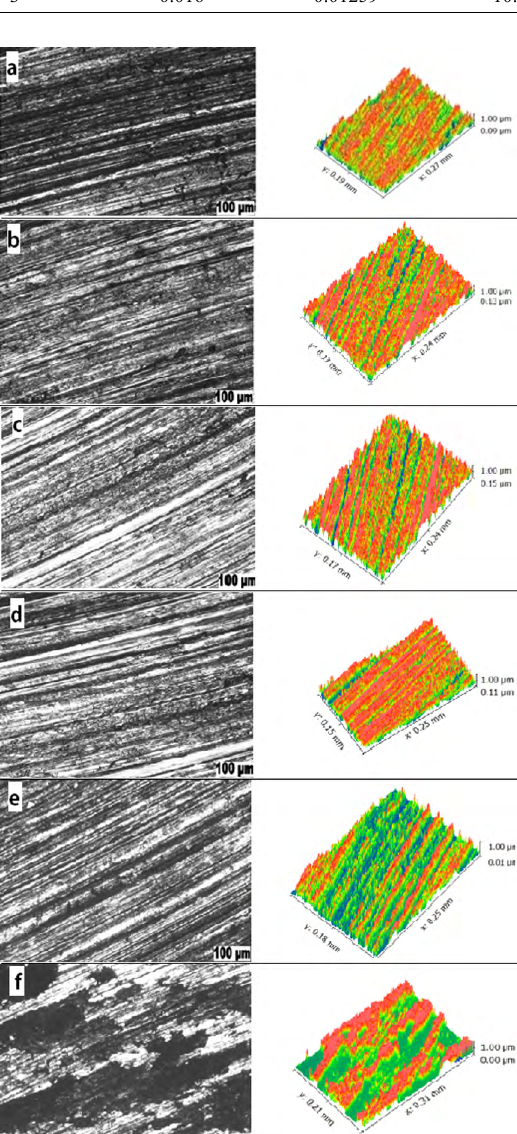
Figure 4. Optical microscopic and WLI images of damaged surface of Aluminium 5059/SiC/MoS at various input conditions.(a)5% 2 &10 µm (b)10% &10 µm (c)5% &20 µm (d)15% &20 µm (e)5%& 40 µm (f)15%&40